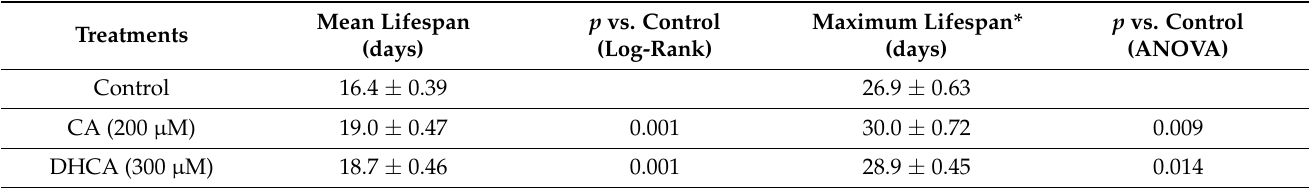
Table 1. Influence of CA (200 µ M) and DHCA (300 µ M) on mean and maximum lifespan of C. elegans under normal growing conditions at 20 ◦ C. The results represent the mean ± SEM ( n = 3). Mean Treatments